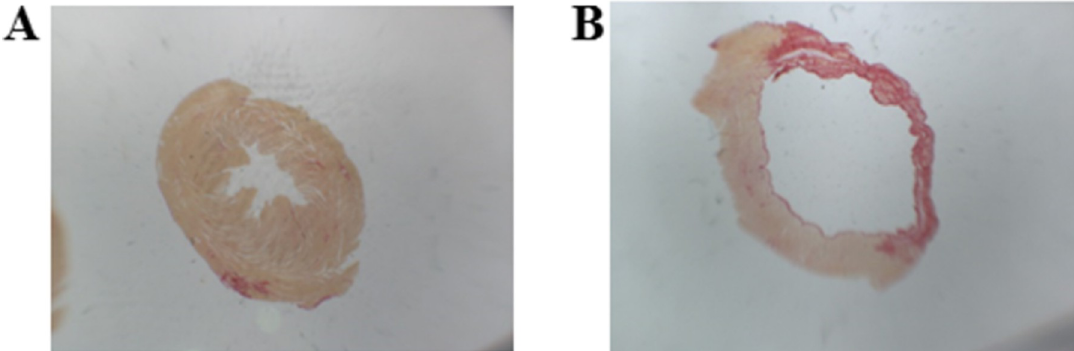
Fig 1. Myocardial infarcted area. (A) Sham animal heart, (B) Infarcted animal heart.